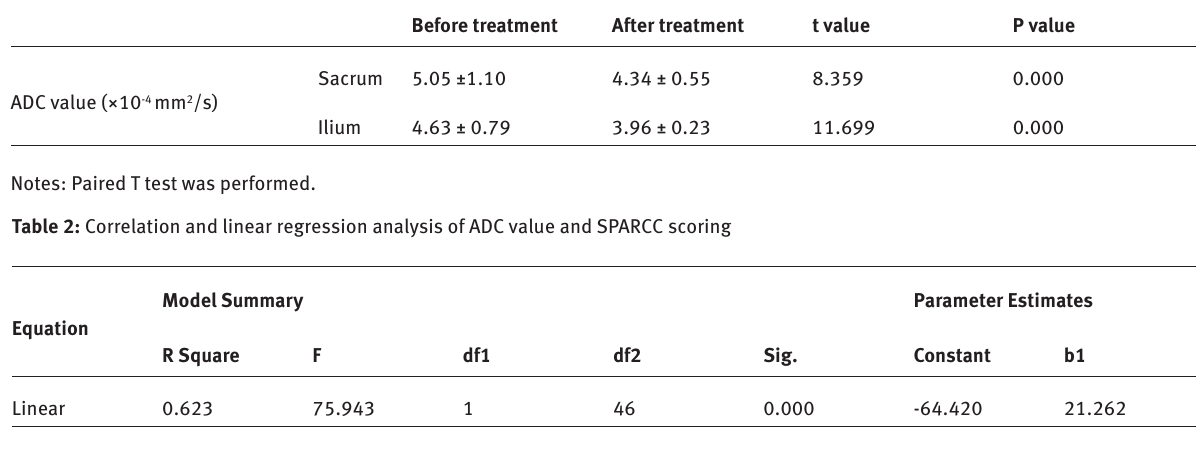
Before treatment